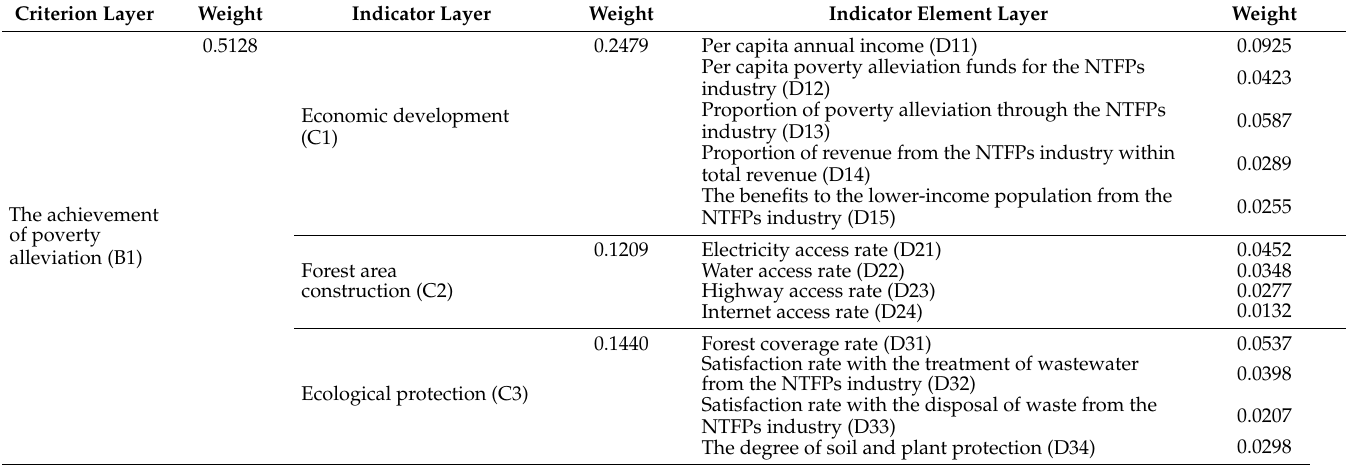
Table 10. The performance evaluation index system for the poverty alleviation performance of the NTFPs industry in Yunnan